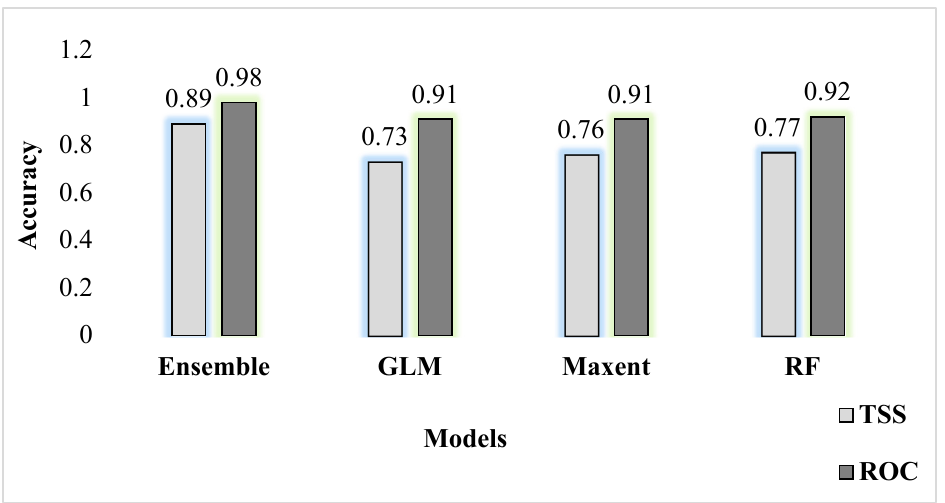
Figure 4. Performance predictions of various modeling approaches used to develop a current suitable habitat model based on true skill statistics.